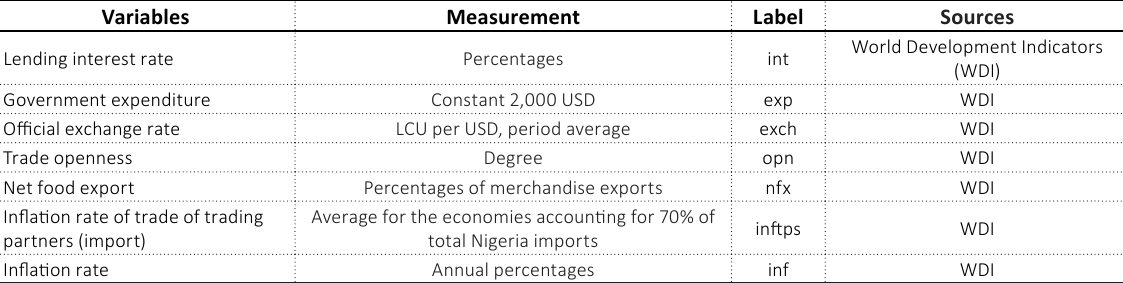
Table 1. Description of